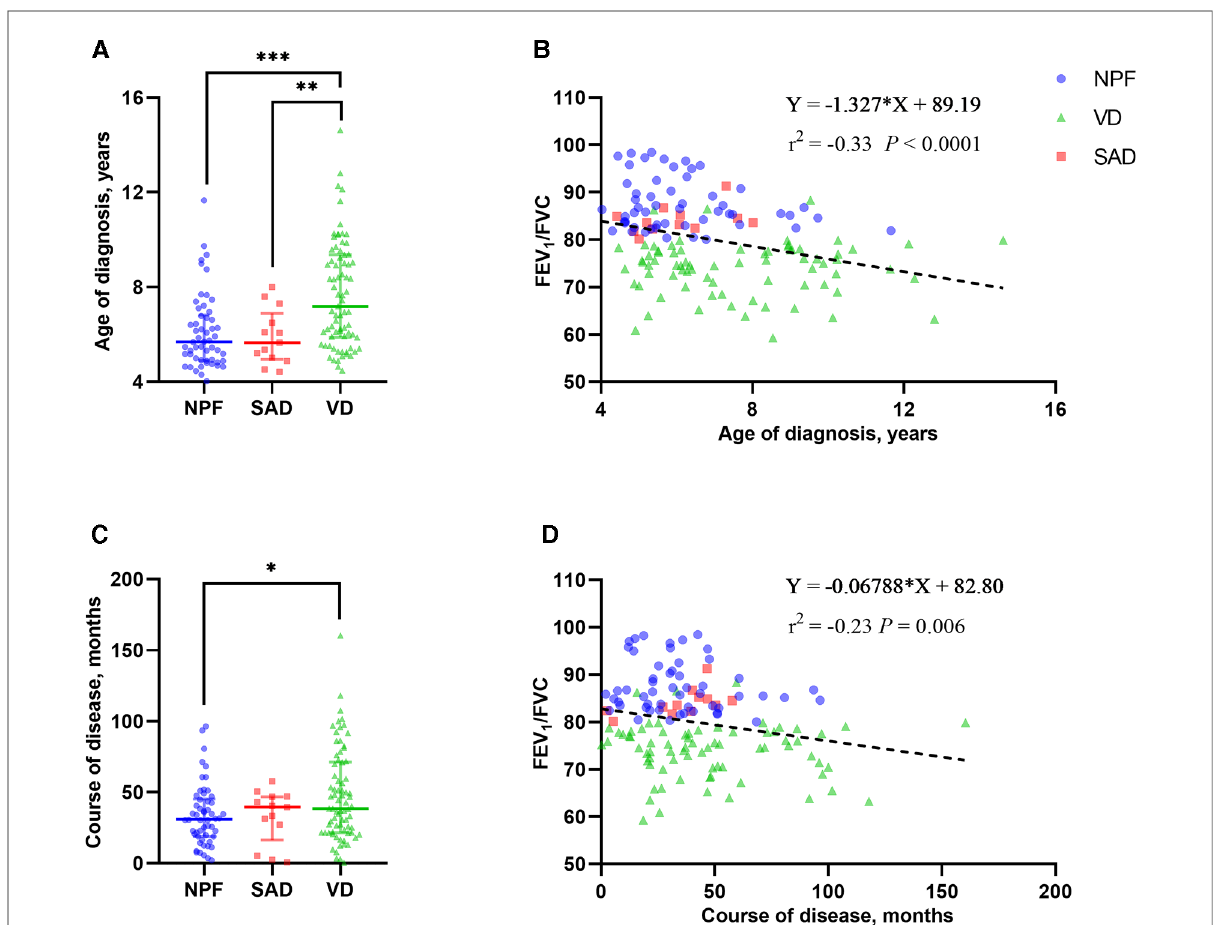
FIGURE 2 Group comparison of age of diagnosis ( A ) and course of disease ( C ) among the three phenotypes in baseline. Linear correlation analysis between FEV 1 /FVC and age of diagnosis ( B ) and course of disease ( D ). NPF, normal pulmonary function phenotype; VD, ventilation dysfunction phenotype; SAD, small airway dysfunction phenotype; FVC, forced vital capacity; FEV 1 , forced expiratory volume in 1s. Bars indicate the median±IQR. Group